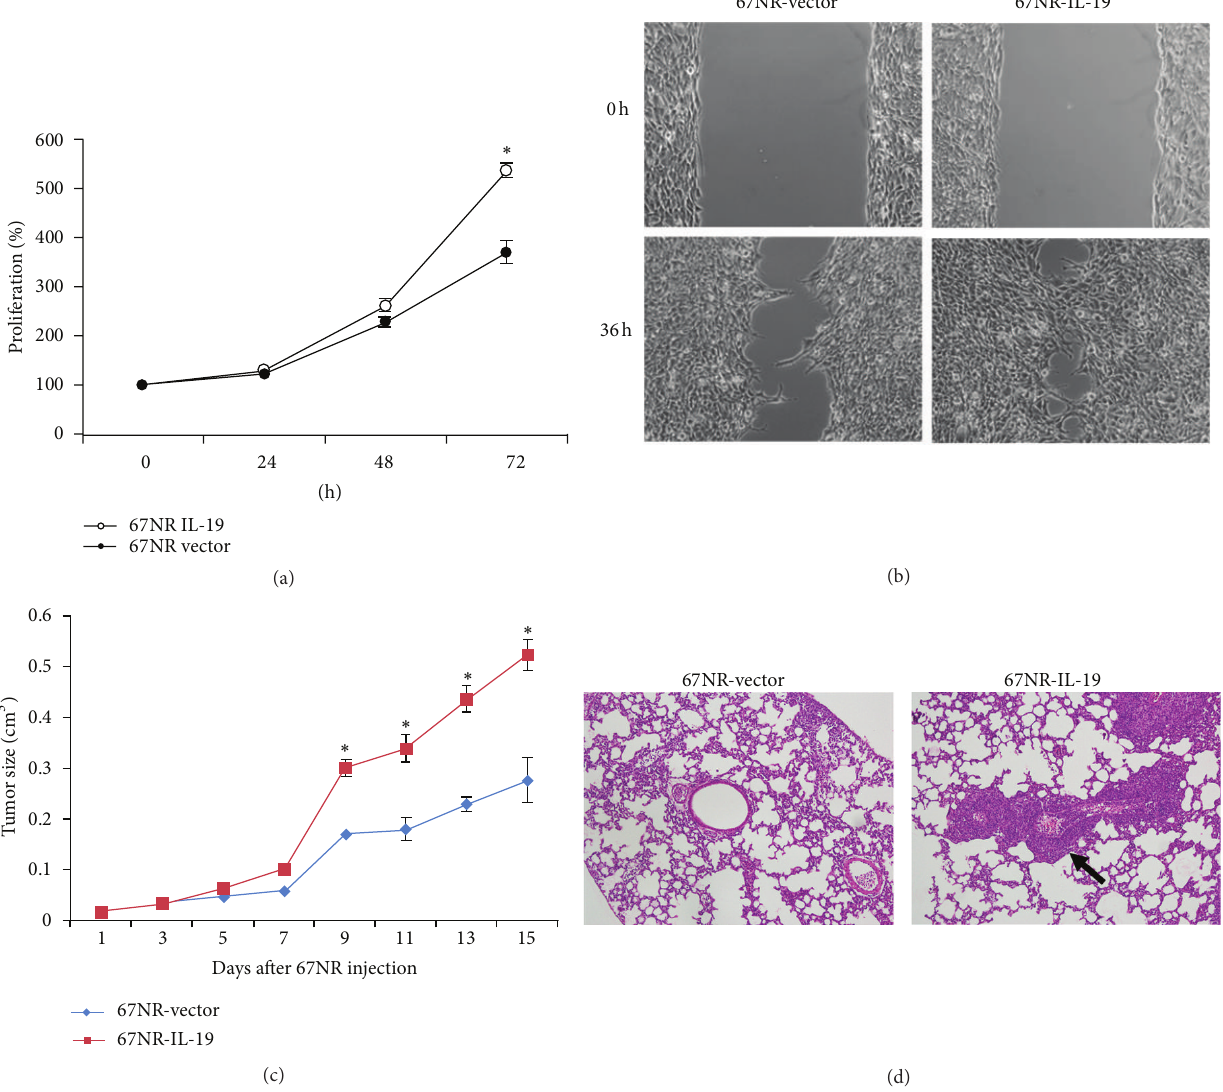
Figure 2: IL-19 overexpression promoted breast cancer cell proliferation and migration in vitro and induced tumor growth and metastasis in vivo . We constructed the IL-19-overexpressing stable clones of 67NR (67NR/IL-19) cells. (a) Proliferation of 67NR/IL-19 cells was significantly higher than that of control cells. Data are mean ± SEM of triplicate experiments. ∗ 𝑃 < 0.05 versus control-vector cells. (b) Cell migration, determined using a wound healing assay, was greater in 67NR/IL-19 cells than in control-vector cells. Quantitative results are shown as a wound healing index. Data are mean ± SEM. ∗ 𝑃 < 0.05 versus control-vector cells. (c) 67NR cells (2 × 10 6 ) were injected into the left mammary fat pads of BALB/c mice and tumor growth was determined. (d) Fifteen days later, the tumors were removed. Thirty days after the tumors had been surgically removed, the mice were killed, and histological analysis showed that lung metastasis (arrows) was significantly higher in 67NR/IL-19 cells than in control cells (magnification, × 100). Data are mean ± SEM ( 𝑛 = 6 mice in each group). ∗ 𝑃 < 0.05 versus control mice. The figure refers to Hsing et al.